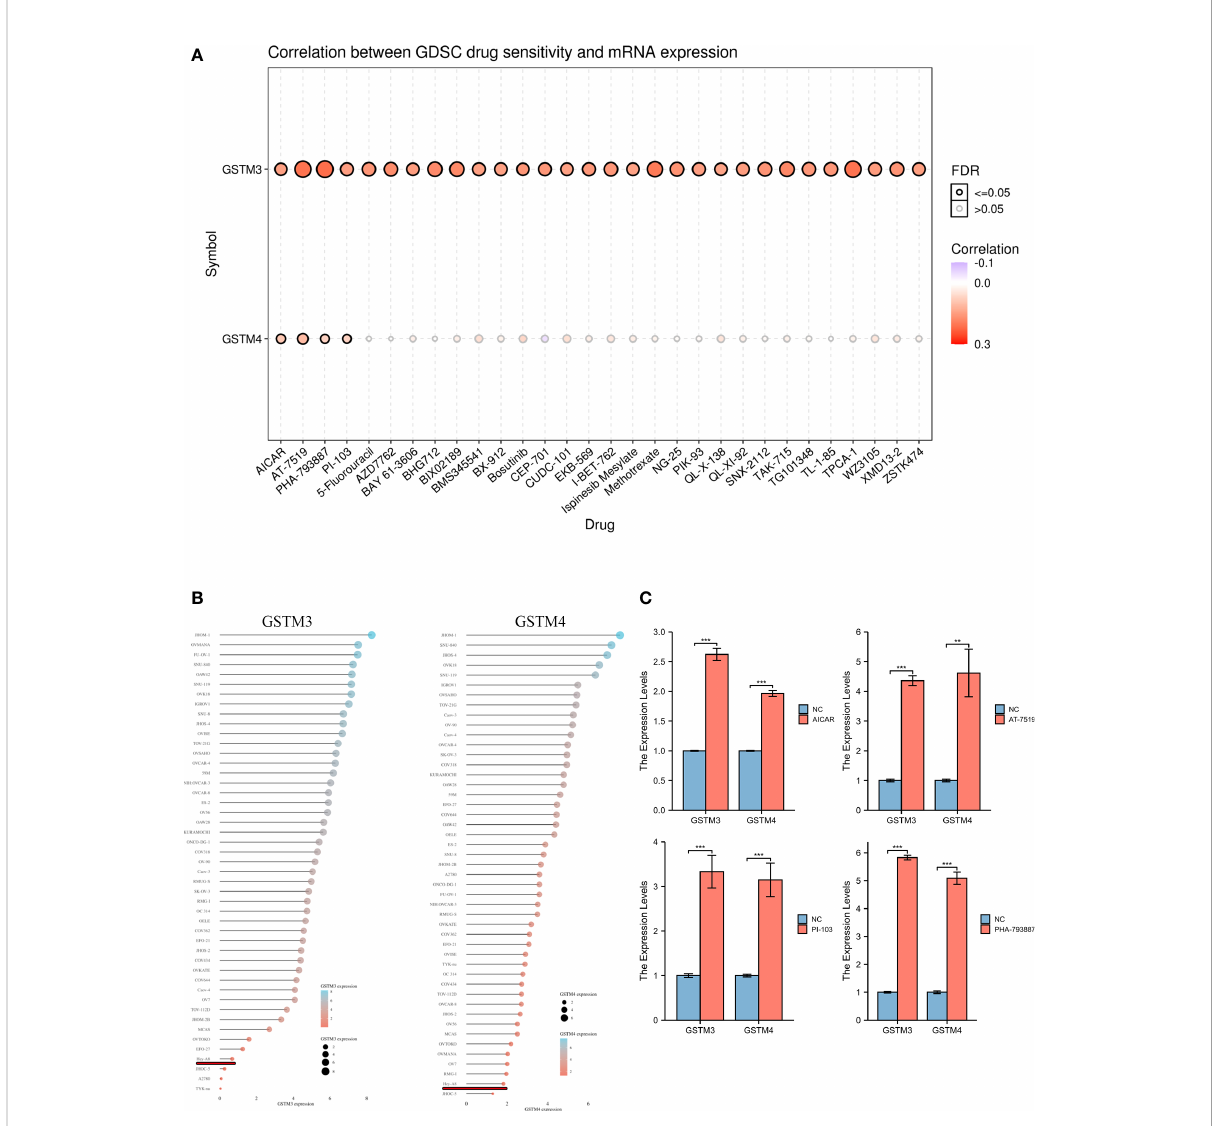
FIGURE 9 The Drug Sensitivity of GSTMs in OC. (A) The effect of multiple drugs on mRNA expression of GSTMs. (B) The mRNA expression of GSTM3/4 in multiple OC cell lines based on CCLE database. (C) The effects of AICAR, AT-7519, PHA-793887 and PI-103 on GSTM3/4 expression level in Hey-A8 cell lines. **p < 0.01; ***p <